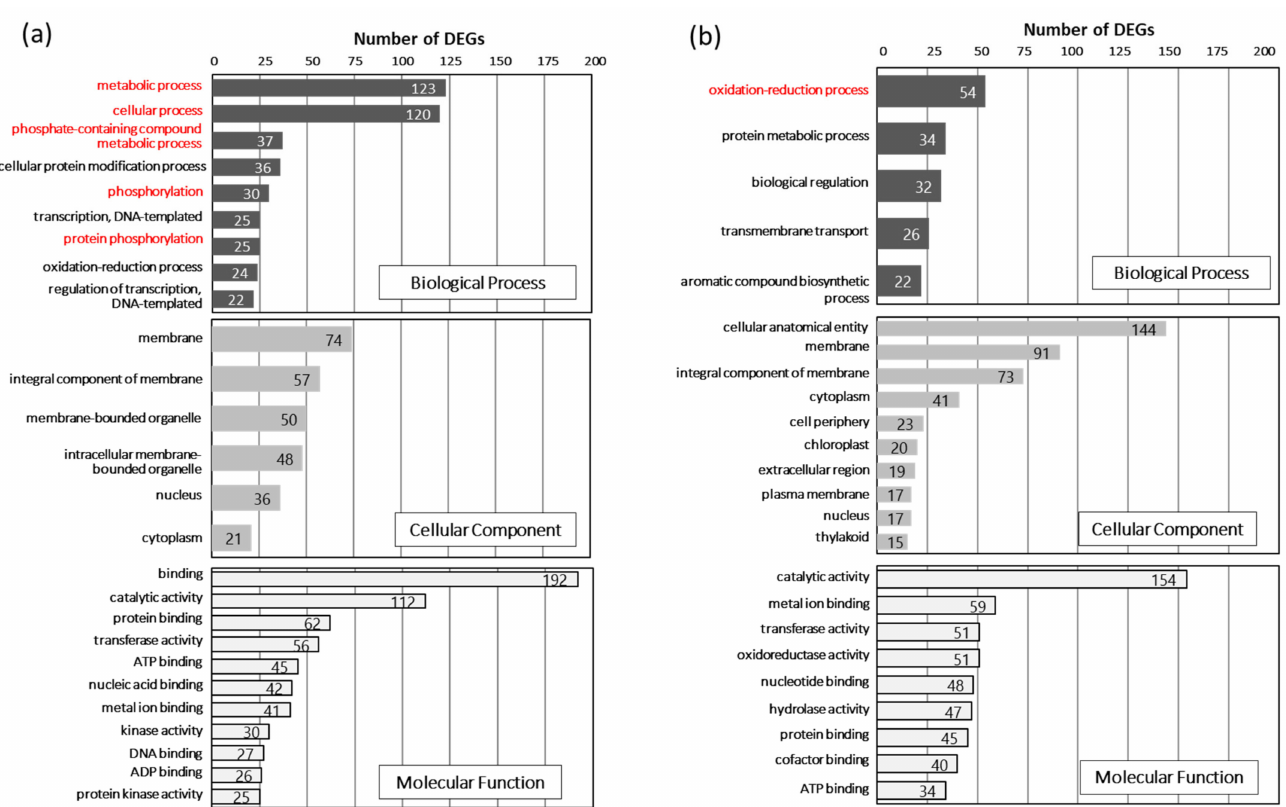
Figure 4. The enriched gene ontology (GO) terms of the identified differentially expressed genes (DEGs) between Kyushu No. 166 (K166) and Tamayutaka at 30 days after inoculation. The GO terms were classified in three categories: biological process, cellular component, and molecular function. ( a ) The top GO terms for the upregulated DEGs in K166; ( b ) the top GO terms for the upregulated DEGs in